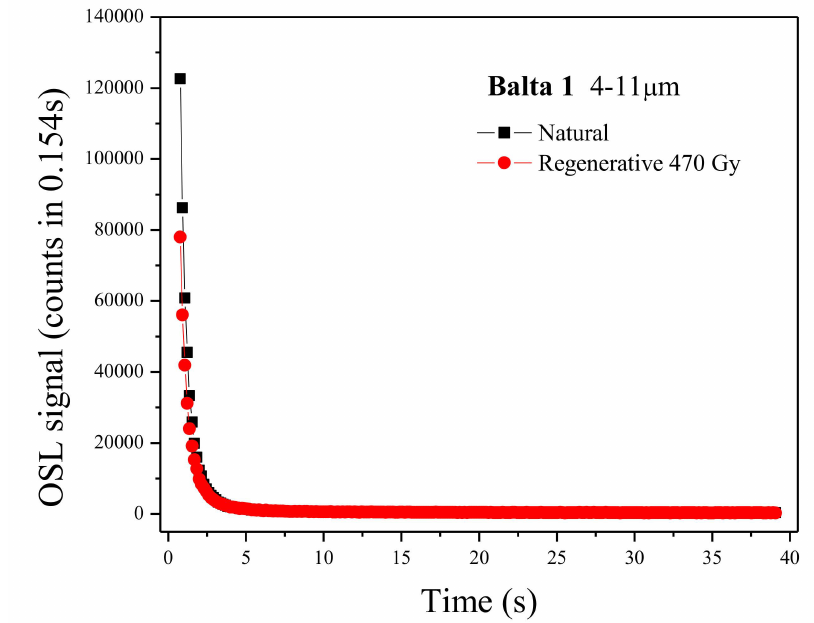
Figure A1. Typical decay curve for 4–11 µ m quartz extracted from sample Balta 1.